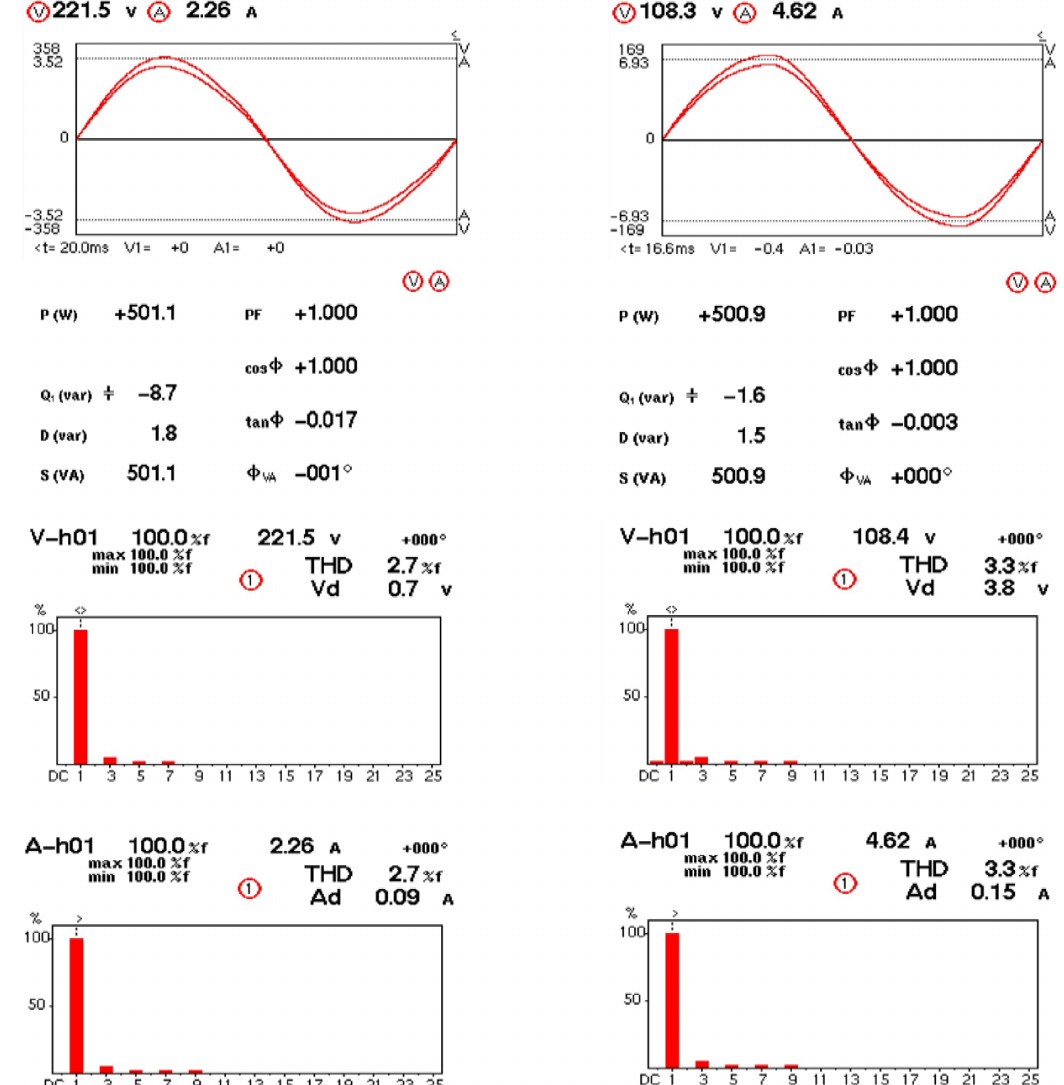
Figure 12. ( Top to bottom ) output voltage and current waveform, power and PF, voltage THD, and current THD, respec- tively. Left for 50Hz operation, right for 60 Hz